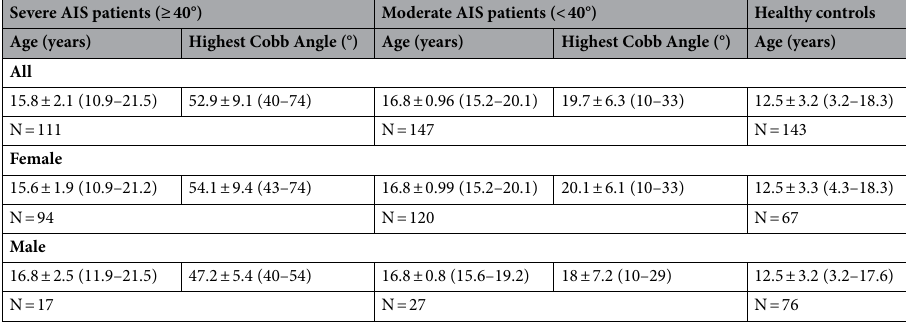
Table 3. Clinical and demographic characteristics of the participants in the second replication cohort.